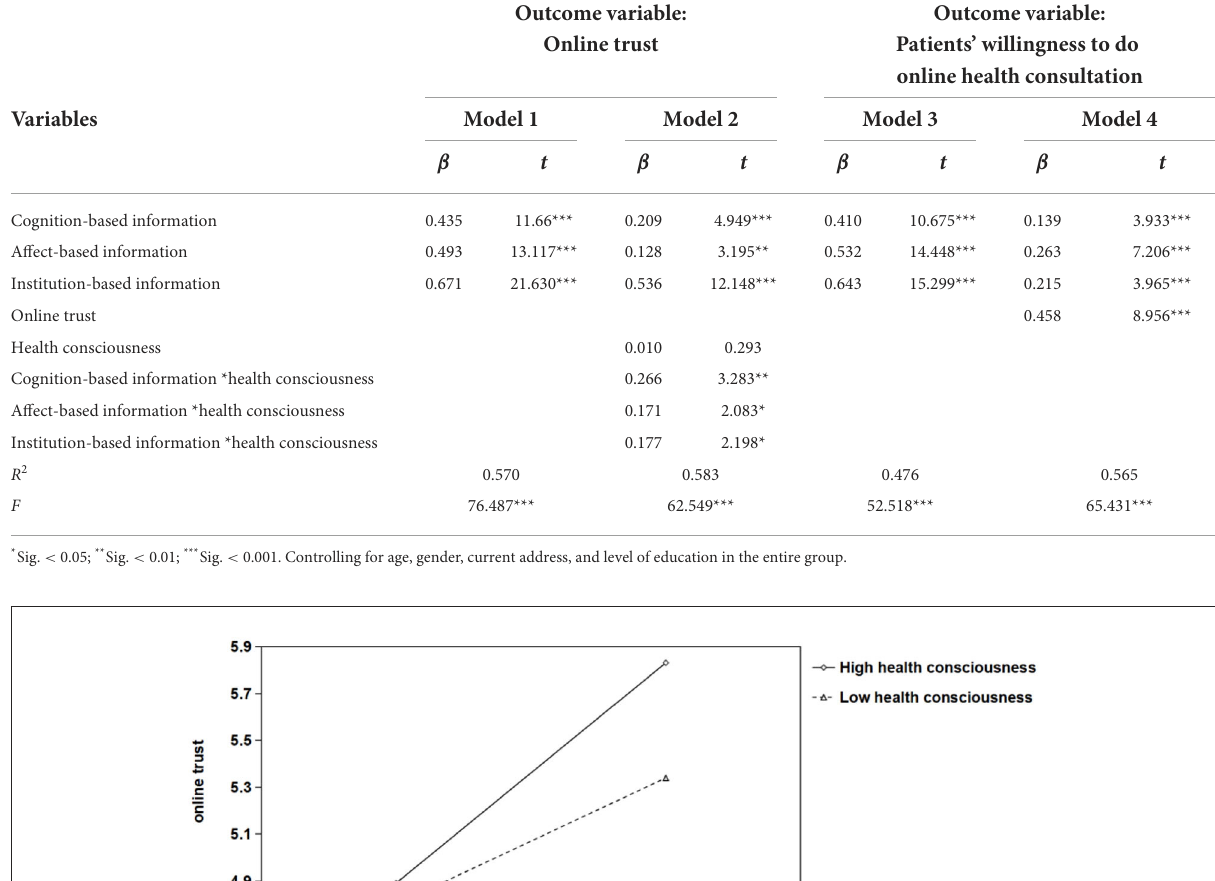
model. The results revealed that the interaction terms of three types of online health platform information and online